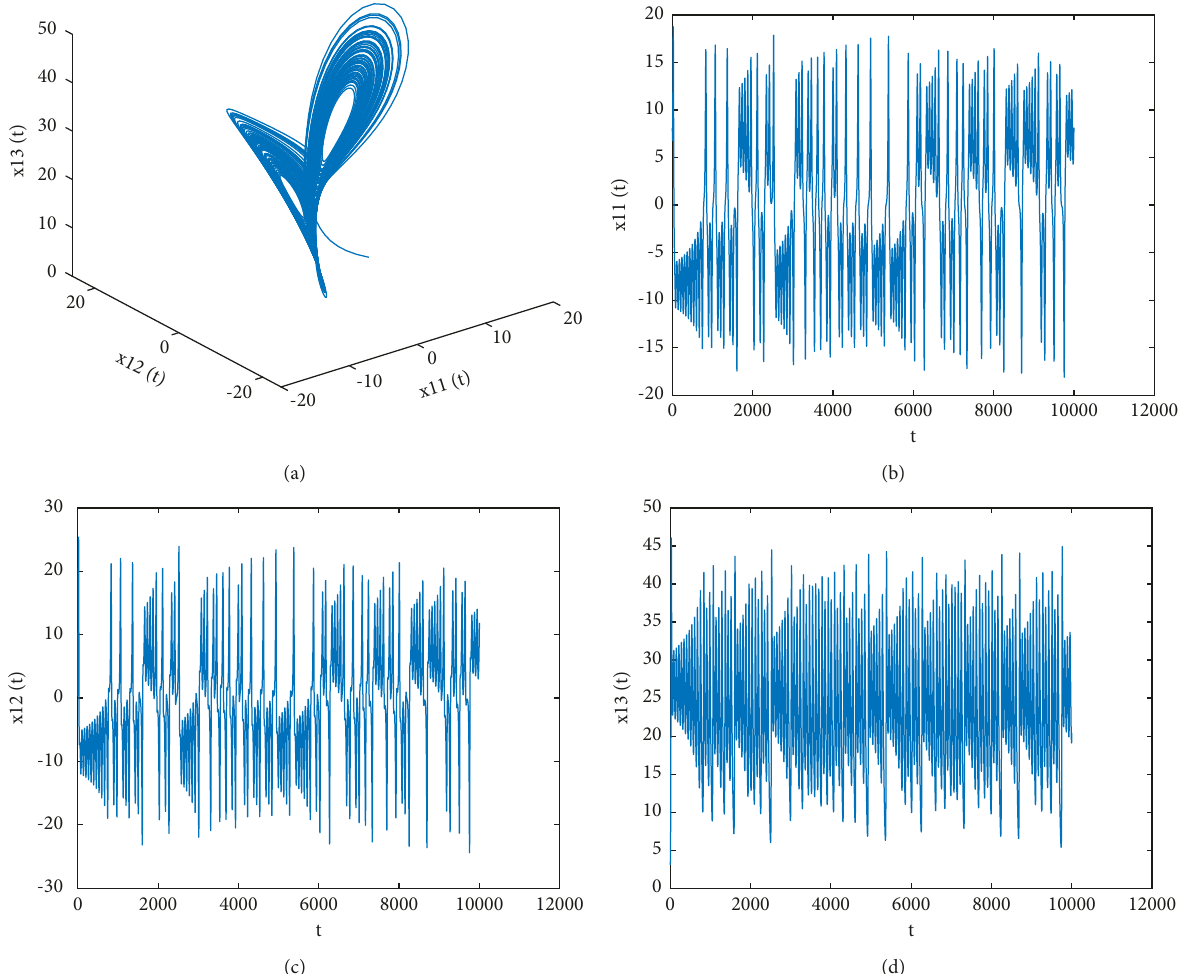
Figure 2: Attractor and time series of the first node of the driving system. (a) Lorenz attractor. (b) x time series. (c) y time series. (d) z time